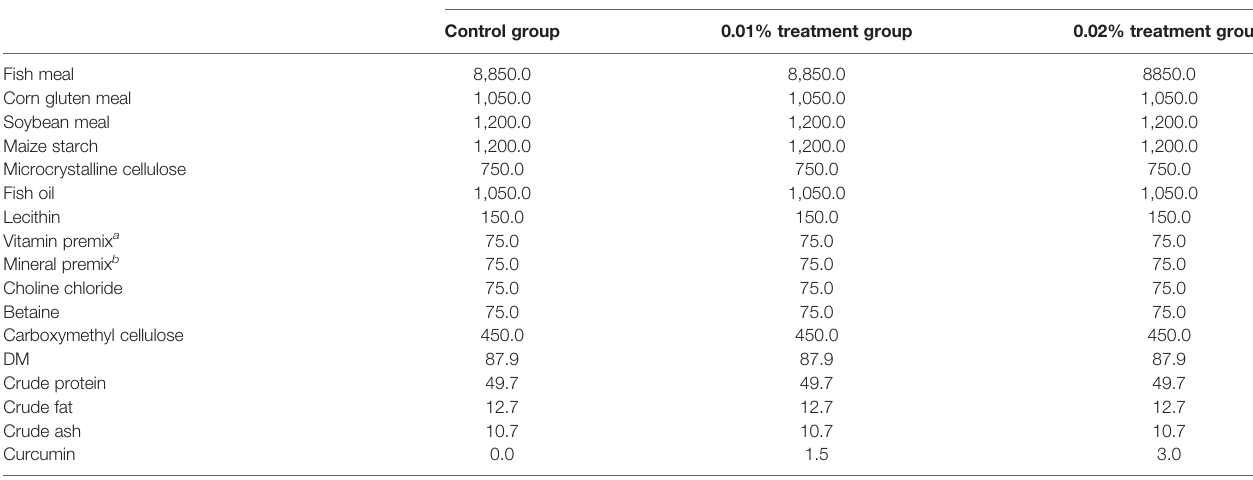
TABLE 1 | Feed formula and ingredient list. Composition and nutritional component The proportion of ingredients in 15,000 g feed (unit: